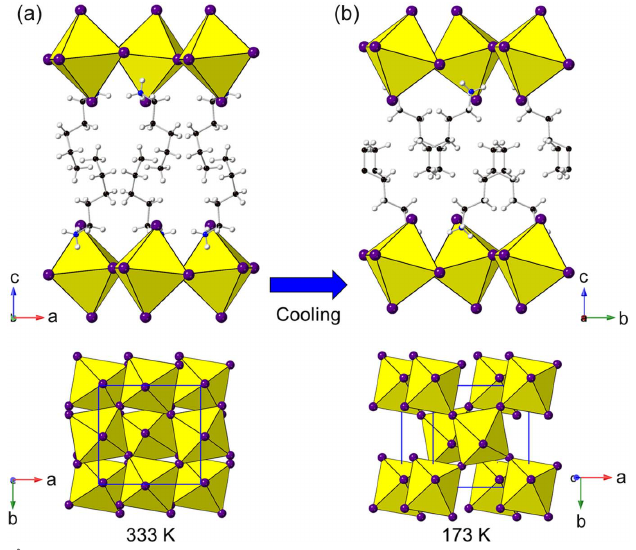
Figure 20 High (665693) and low (665691) temperature phases of [C 5 H 14 N] 2 PbI 4 adopting Pbca and P 2 1 / a structures, respectively. Note the change in degree of layer shift corresponding to the change in amine